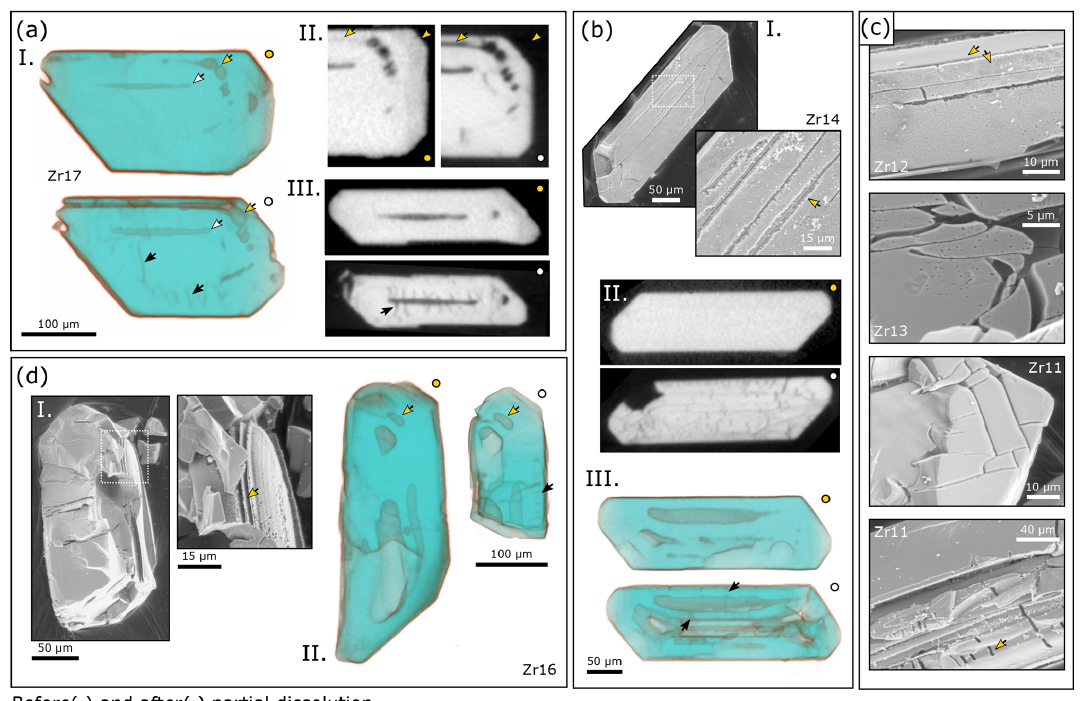
Figure 9. SE and µCT images of AS3 grains pre- and post-chemical abrasion (yellow dots and white dots, respectively) at 180 ◦ C for 4h. (a) Subpanel (I) shows semi-transparent 3D renderings of µCT data for Zr17, showing melt inclusions removed by partial dissolution (yellow and white arrows) and newly visible fractures (black arrows). (II) 2D µCT image slices showing the removal of a metamict rim and interior zone. (III) 2D µCT cross section of the melt inclusion marked by white arrows in (I). Newly visible radial fractures have developed along the length of the melt inclusion (black arrow). (b) Subpanel (I) shows SE images of Zr14, showing the widening of fractures on the grain surface. (II) 2D µCT image slices showing a fracture network after partial dissolution. (III) 3D rendering of µCT data showing radial fractures (black arrows) around large melt inclusions removed by partial dissolution. (c) SE images of zircon residues illustrating the contrast between a smooth, low-damage surface and a higher-damage pitted surface (Zr12), curved acid paths, small etch pits (Zr13), blocky fractures (Zr11 top), and dumbbell-like dissolution features (Zr11 bottom). (d) Subpanel (I) shows SE images of Zr16, showing the removal of fine-scale zones. (II) 3D rendering of µCT data showing the removal of large melt inclusions (yellow arrows), the formation of a parallel fracture sequence (black arrow), and significant volume loss, likely due to breakage along the grain center where there are two giant melt